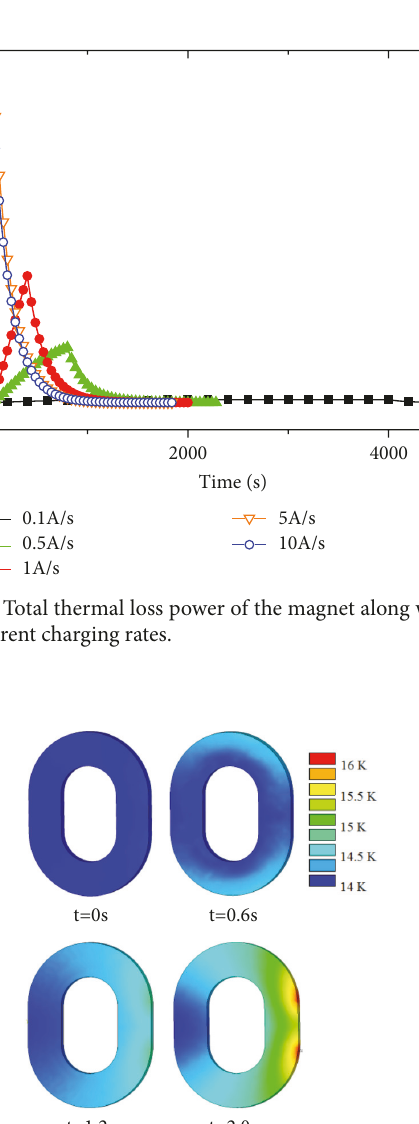
= 50 A and K = 100 A/s. d